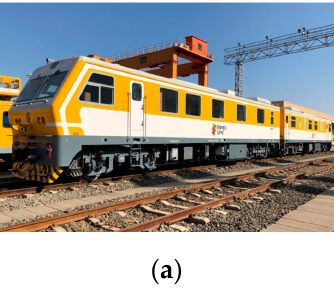
Figure 3. The track inspection car and wheelset distances: ( a ) track inspection car; ( b ) wheelset distance parameters of track inspection.